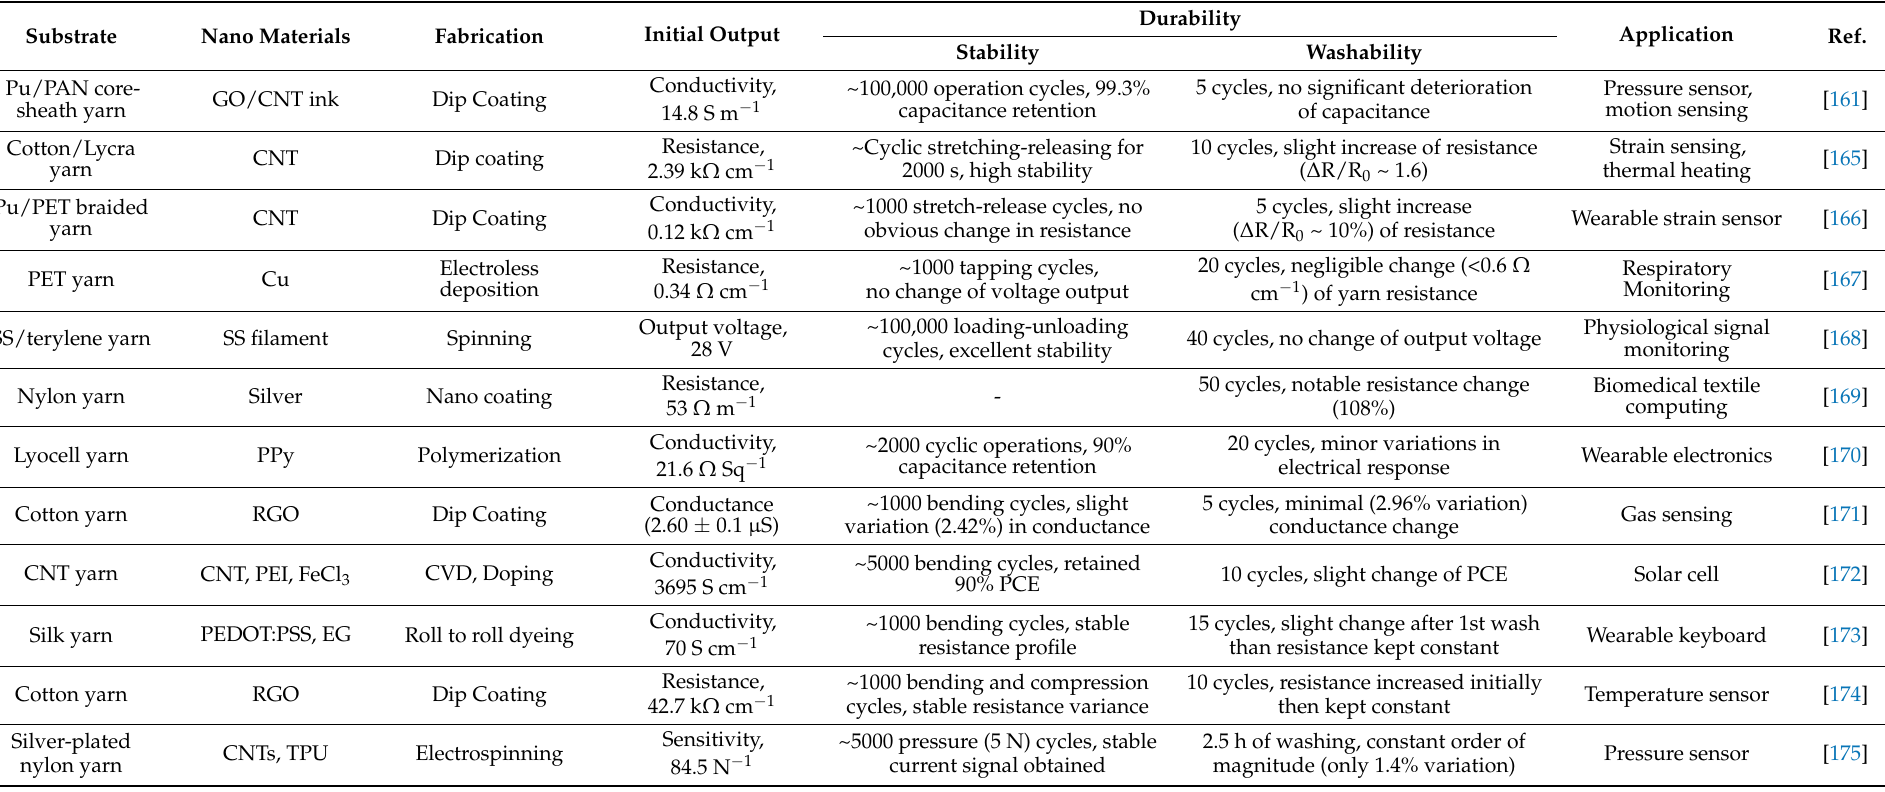
Table 1. Summary of different yarn-shaped durable wearable electronic